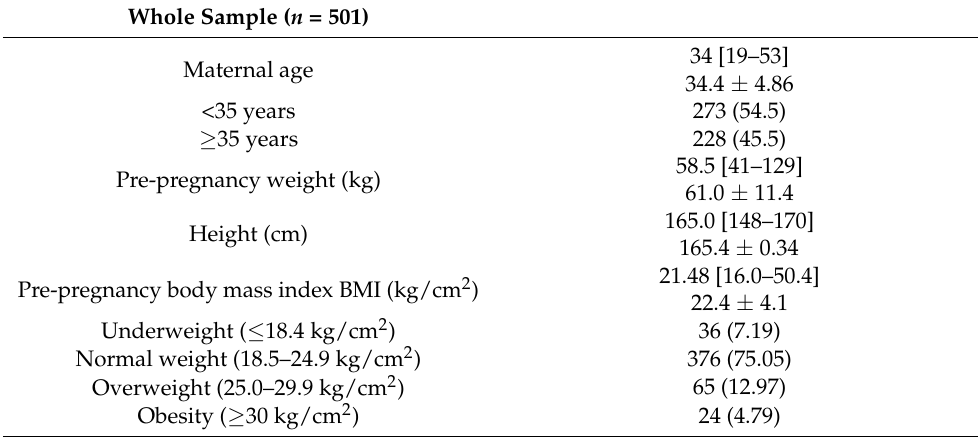
Table 1. General characteristics of the study